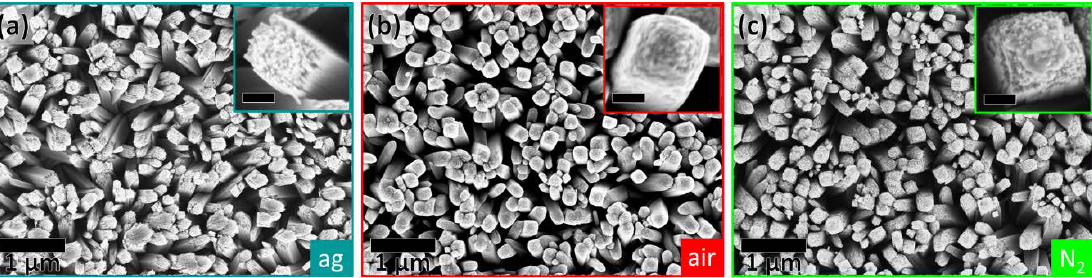
Figure 1. Scanning electron microscopy (SEM) images of nanowire (NW) arrays, which are ( a ) as-grown (ag), ( b ) annealed in air, and ( c ) annealed in N 2 . The insets show a high magnification SEM image of a single NW from the respective NW array. The scale bar of the inset is 50 nm.